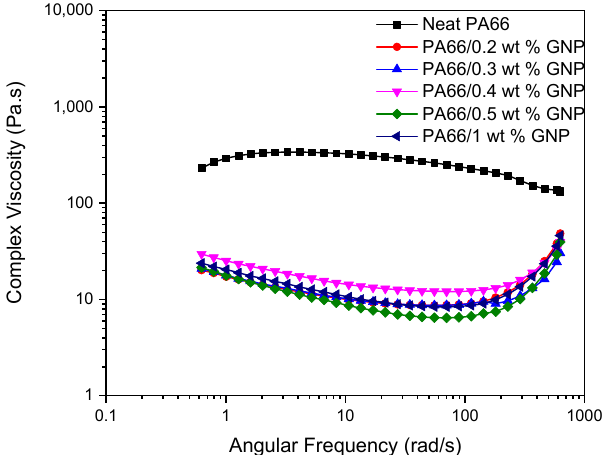
Figure 8. Complex viscosity of neat PA66 and its GNP-based nanocomposites as a function of angular